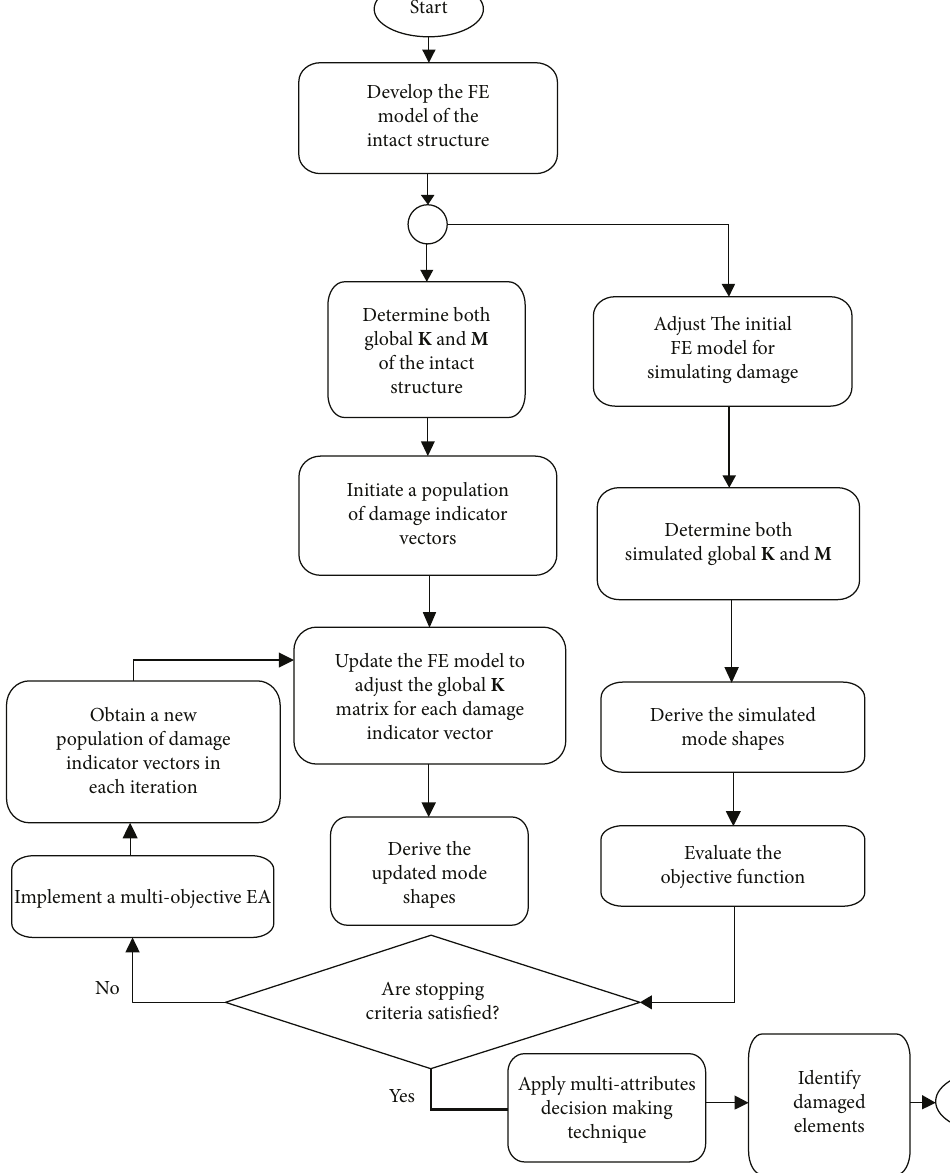
Figure 1: Damage prognostic paradigm using the MOEAs and FE model